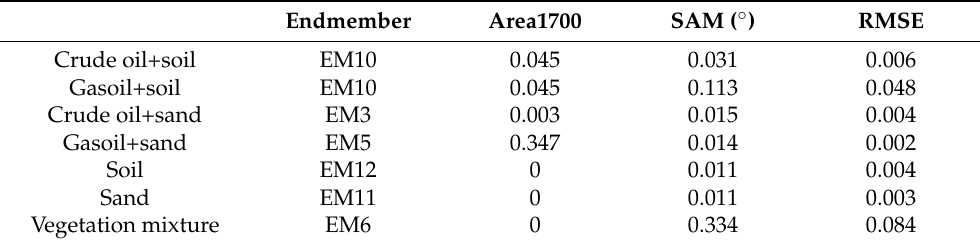
Table 2. Area1700 endmember values (values of the remaining endmembers are equal to 0), spectral angle values between each component and the closest endmember (considering spectral angle), and the corresponding RMSE. OSPv1: OSP applied to the entire image after vegetation rejection.